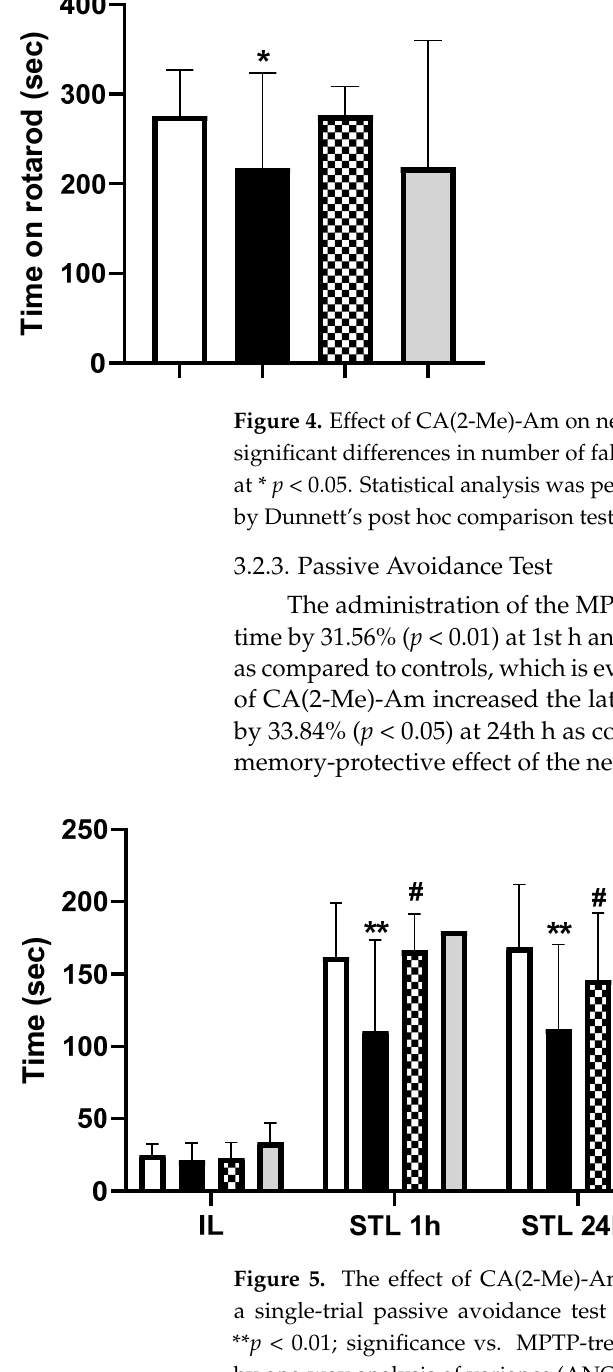
Table 2. Molecular docking score (kcal/mol) of ( E )– N -(2-methylcinnamoyl)-amantadine against se- lected targets associated with PD.